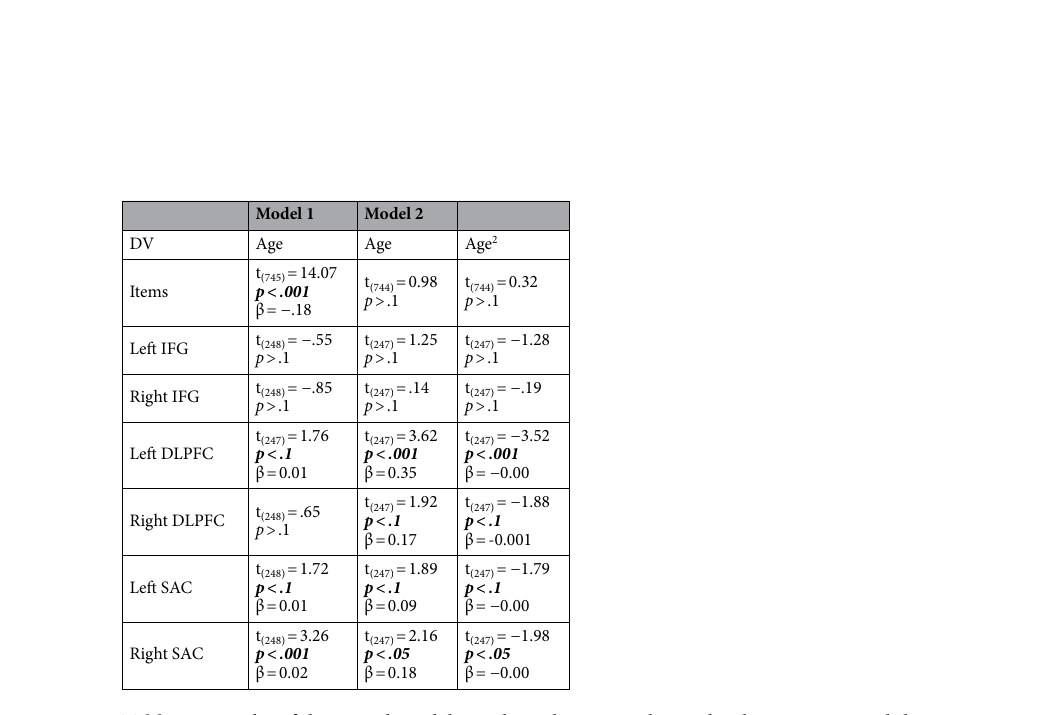
Table 2. Results of the mixed models on the polynomic relationship between age and the